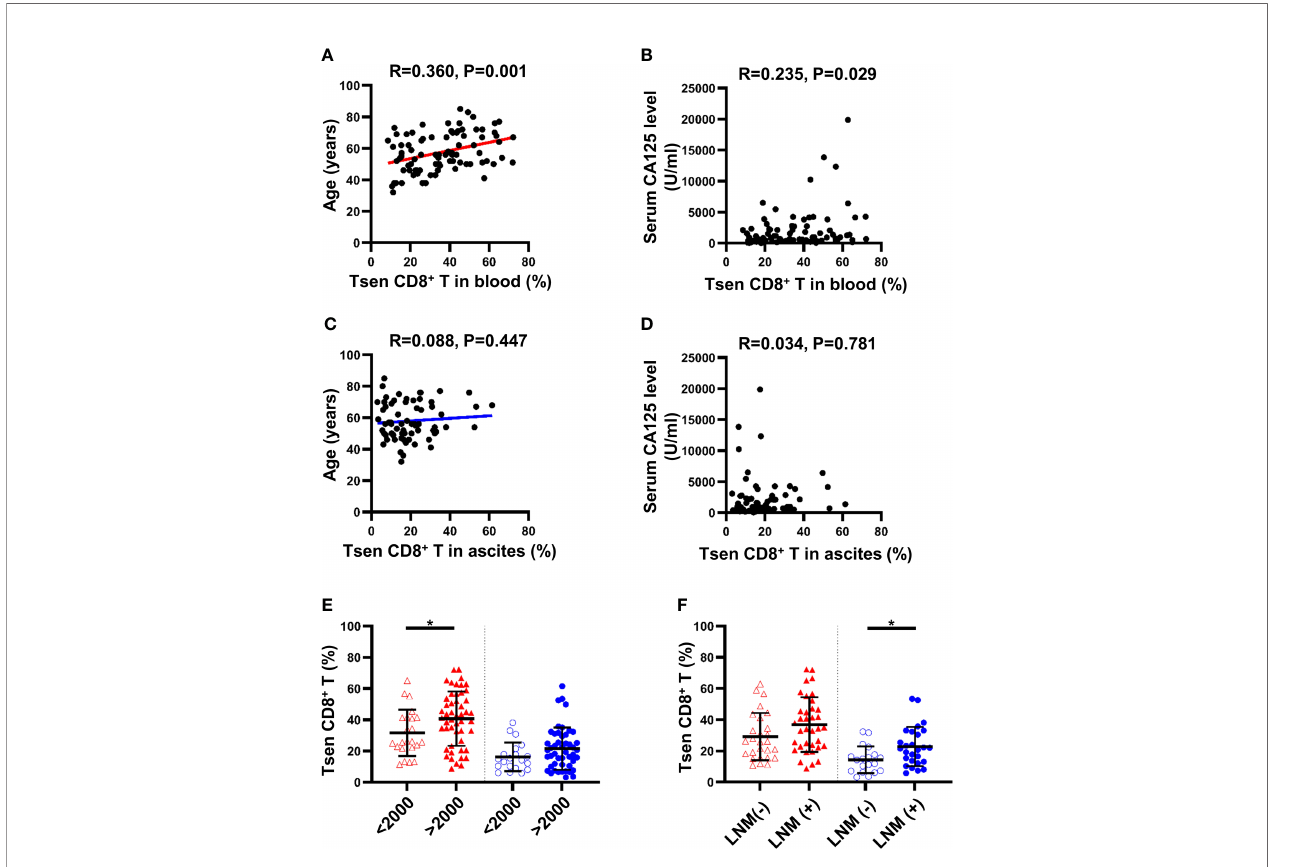
FIGURE 2 | Clinical parameters and differences in proportion of Tsen CD8 + T cells in the peripheral blood and ascites of patients with HGSOC. The correlation between age and Tsen CD8 + T cells in (A) peripheral blood and (C) ascites was analyzed by linear regression test. Spearman ’ s rank coef fi cient was used to examine the correlation between serum CA125 level and Tsen CD8 + T cells in (B) peripheral blood and (D) ascites. Patients were grouped according to (E) ascites volume (peripheral blood: ascites volume <2,000 ml, n = 23, vs. ascites volume >2,000 ml, n = 50; ascites: ascites volume <2,000 ml, n = 20, vs. ascites volume >2,000 ml, n = 48) and (F) lymph node metastasis [peripheral blood: LNM ( − ), n = 27, vs. with LNM (+), n = 36; ascites: LNM ( − ), n = 19, vs. LNM (+), n = 27]. Groups were compared using t-test. Bars show mean with SD. *, P <